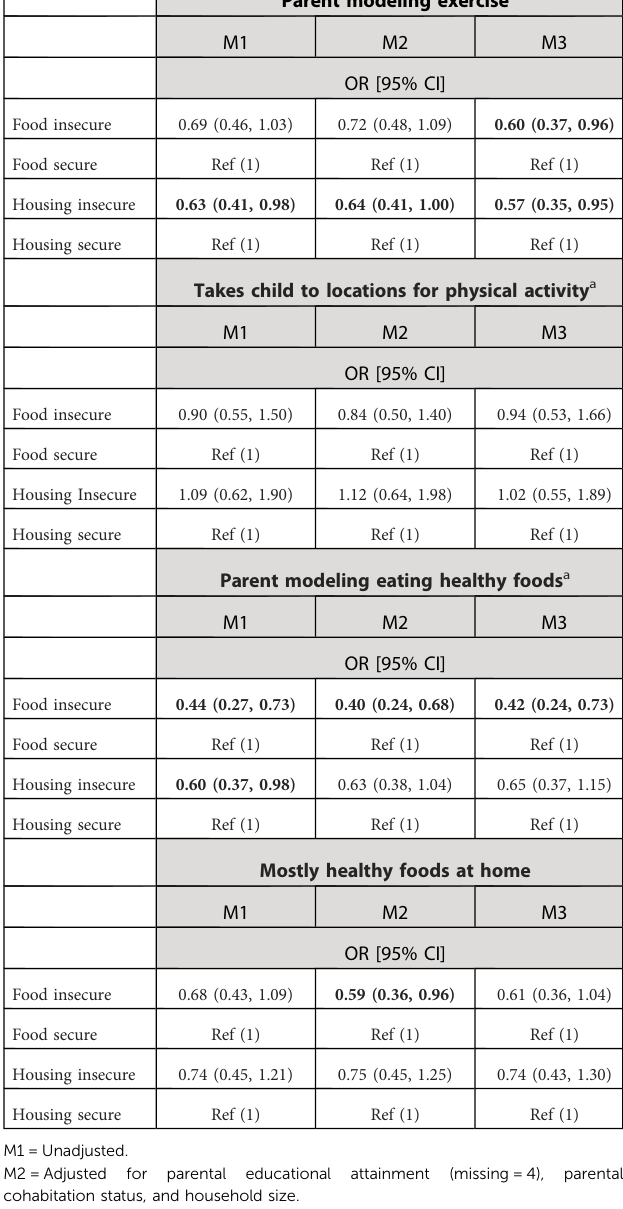
TABLE 2 Logistic regression models for association between food and housing security status and healthy lifestyle parenting behaviors ( N =407). Parent modeling